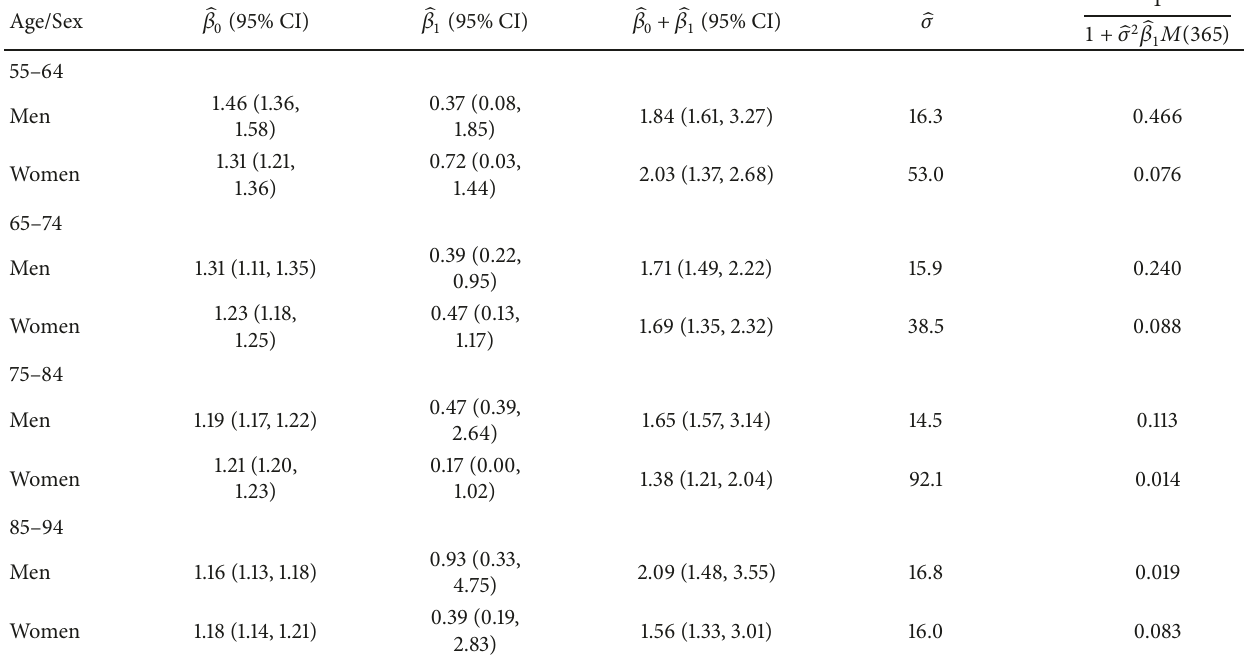
Table 2: Estimated parameters with Bootstrap confidence intervals (CI), 1000 repetitions. 𝑀(365) is the cumulative mortality rate for the married at time 𝑡 = 365